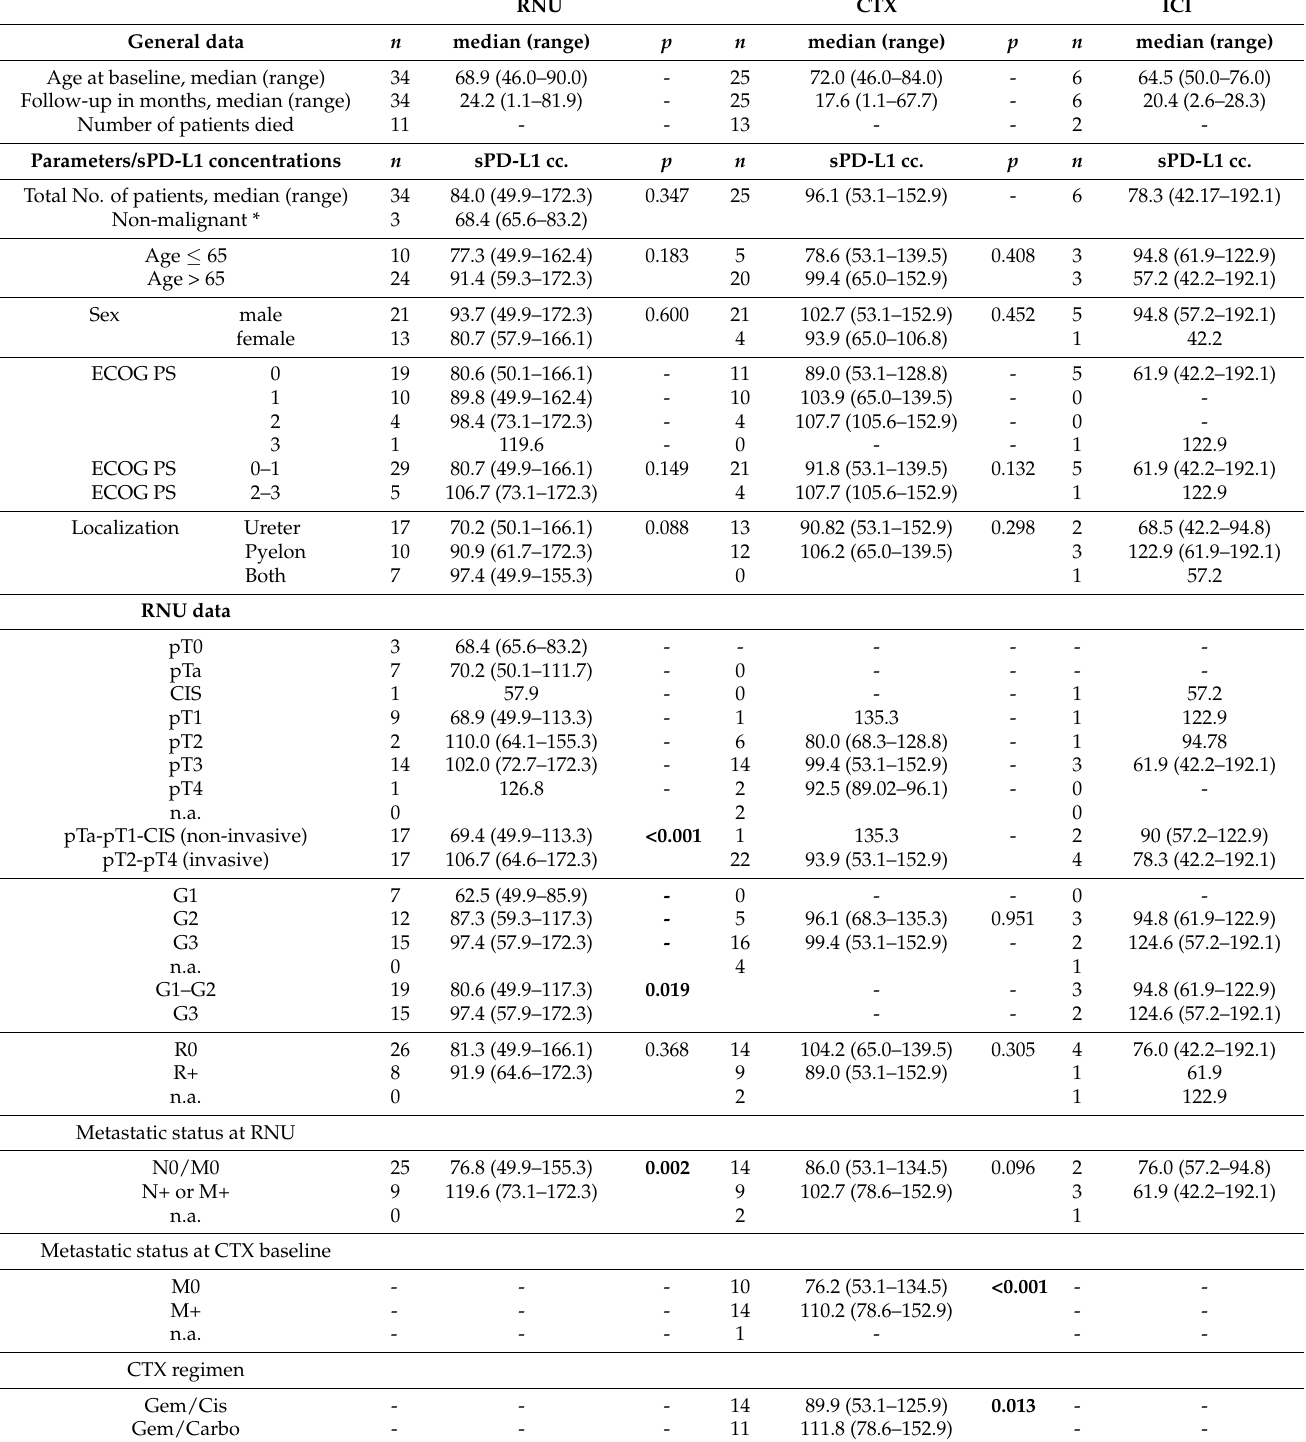
Table 1. Patients’ characteristics for RNU, CTX and ICI treatment groups. * Non-malignant—in